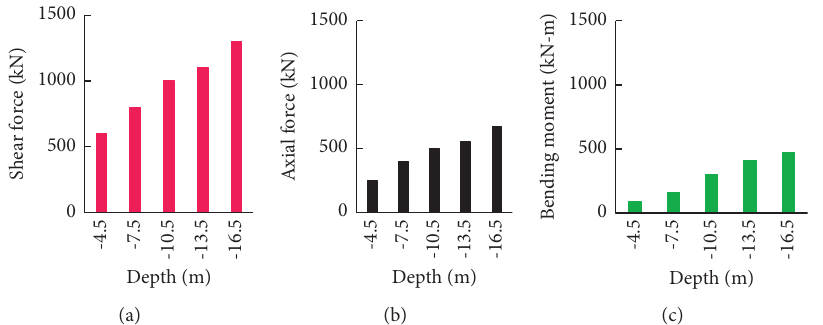
Figure 11: Influence of the application of steel bracing support with servo geotechnology axial loading capacity enhancement on wall (a) shear force, (b) axial force, and (c) bending moment.